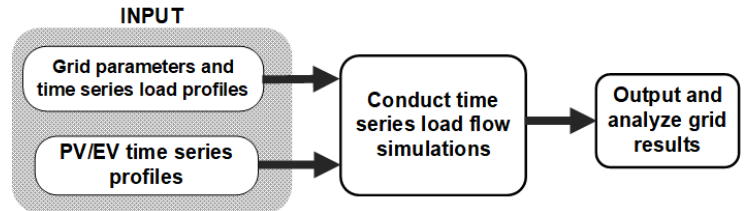
Figure 4. Time series method illustration.